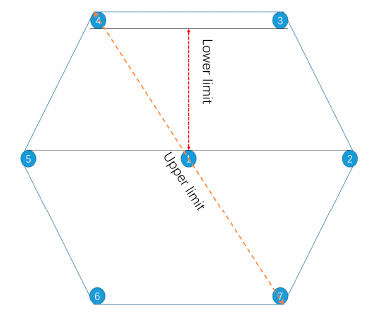
Figure 9. Seven-core end face.